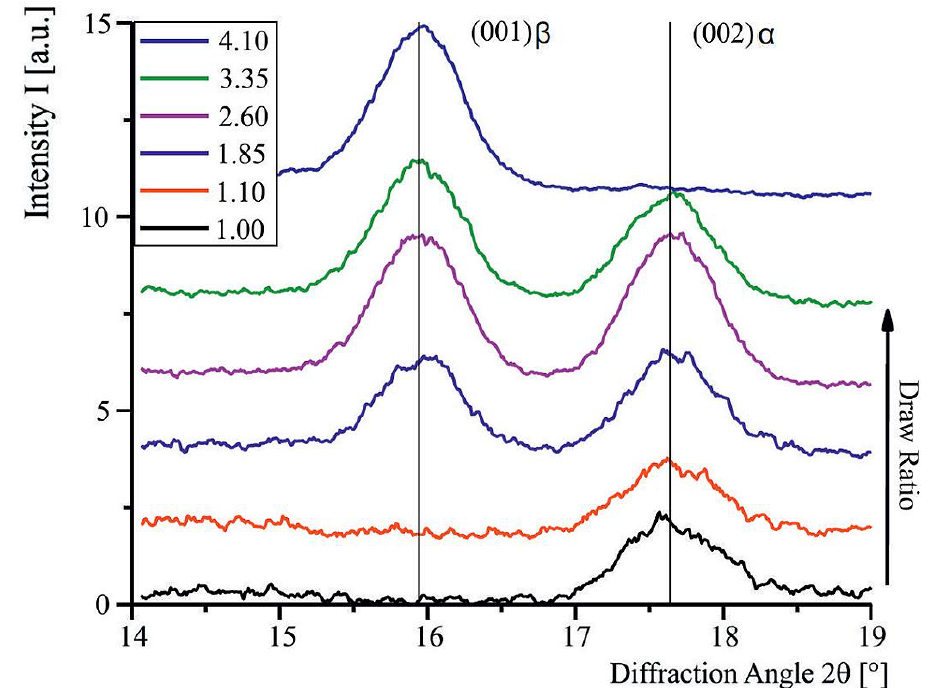
Figure 9. α and β phase intensity distributions for fibers drawn at different draw ratios.